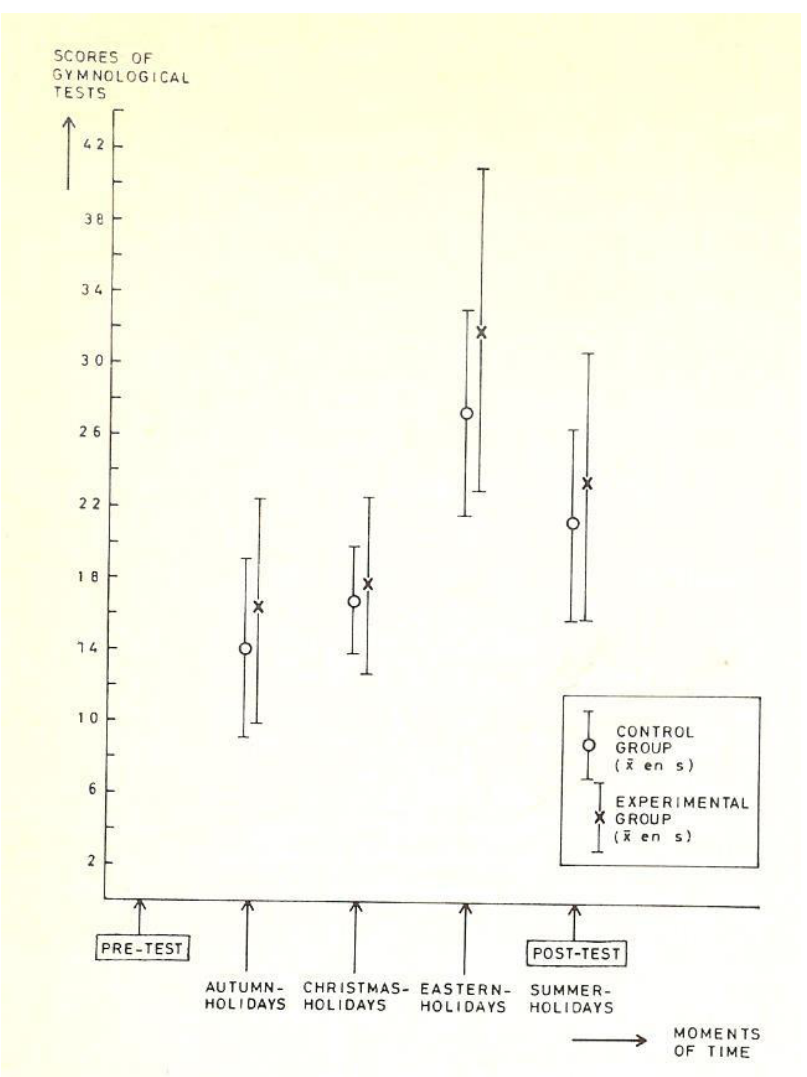
Figure 2. Mean and standard deviation of gymnologic scores of experimental groups (black crosses) and control group (open symbols) during the four periods of measurement